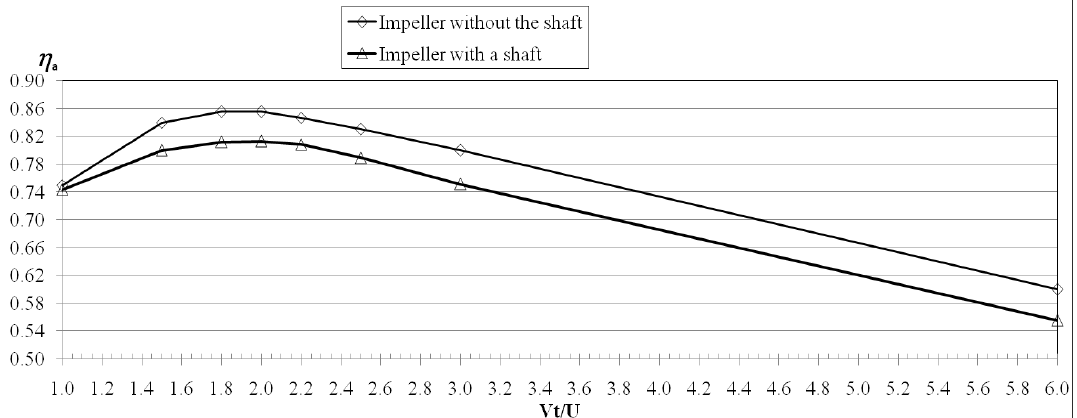
Figure 19. Efficiency curves of the turbine with and without the rotating